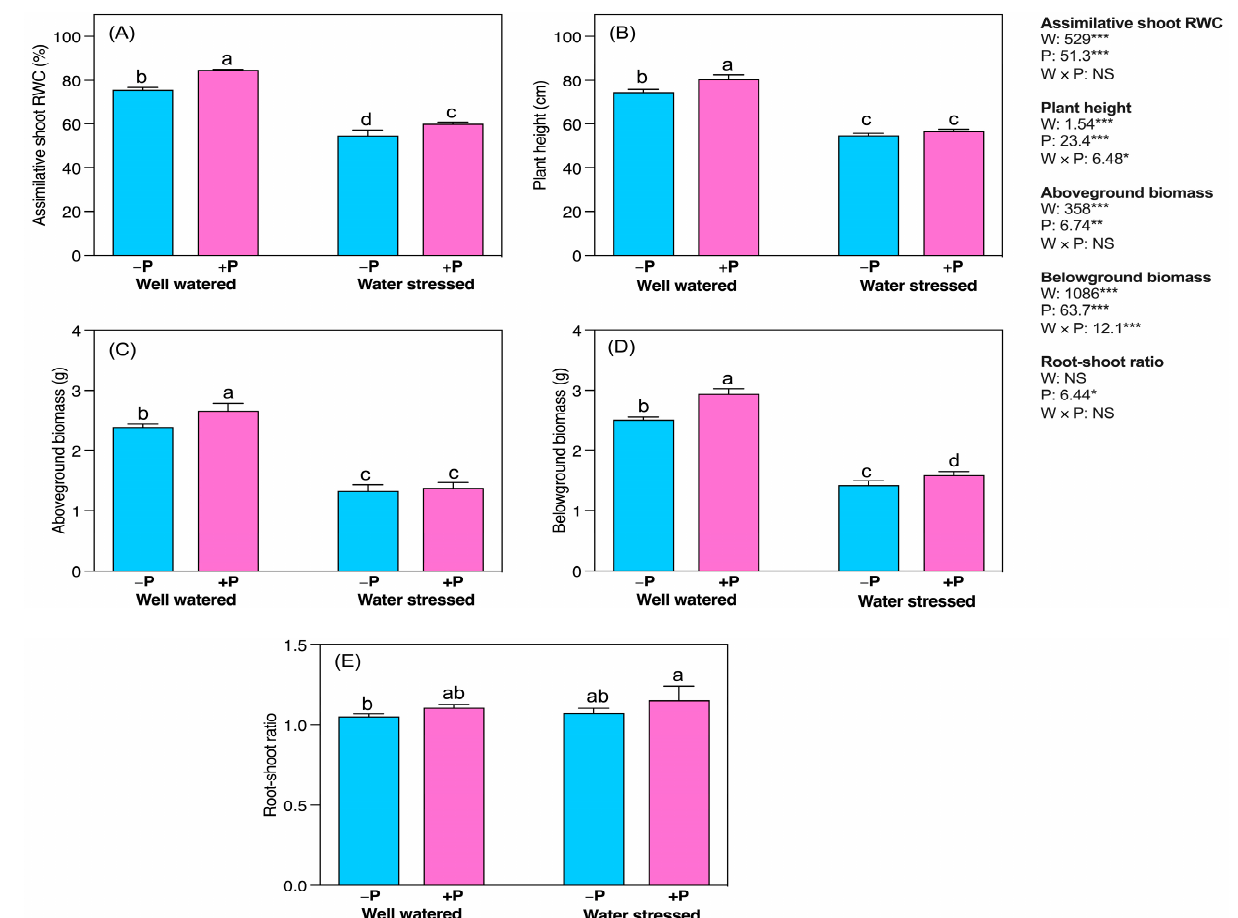
Figure 1. Changesin( A )assimilative shoots RWC, ( B )plant height, ( C )above ‑ ground biomass, ( D ) below ‑ ground biomass, and ( E ) root ‑ shoot ratio inresponse to P supplementation, under well ‑ watered and drought-stressed conditions. A different letter following the means indicates significant differences ( p < 0.05) between the four treatments, as determined by Duncan’s test. Bars represent means ±SD. An overview of the two ‑ way ANOVA assessing the effect of water (W) and phosphorus (P) treatments is presented in the right-hand corner of each panel. *, ** and *** indicate that F values were significant at p ≤ 0.05, 0.01, and 0.001, respectively.